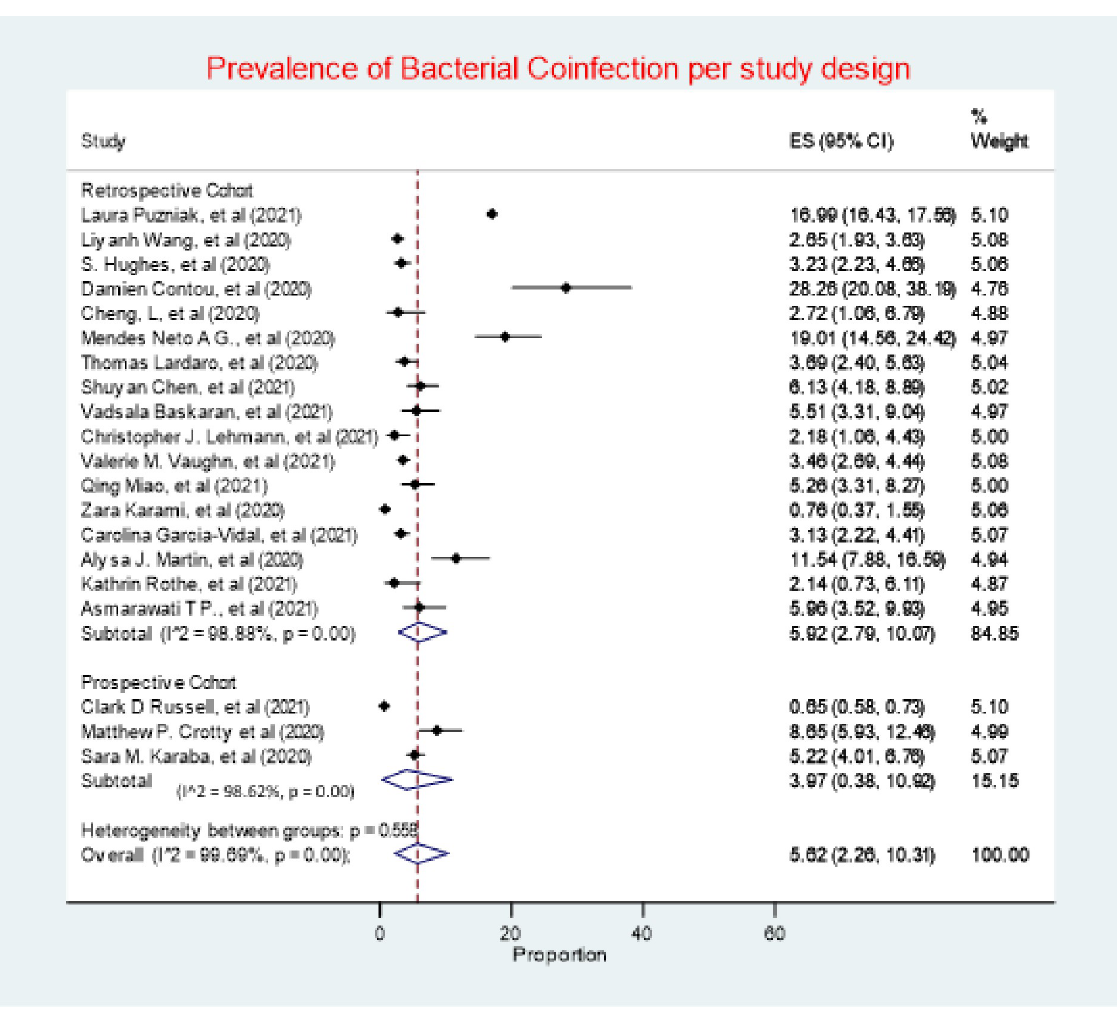
Fig 5. Prevalence of bacterial coinfection by study